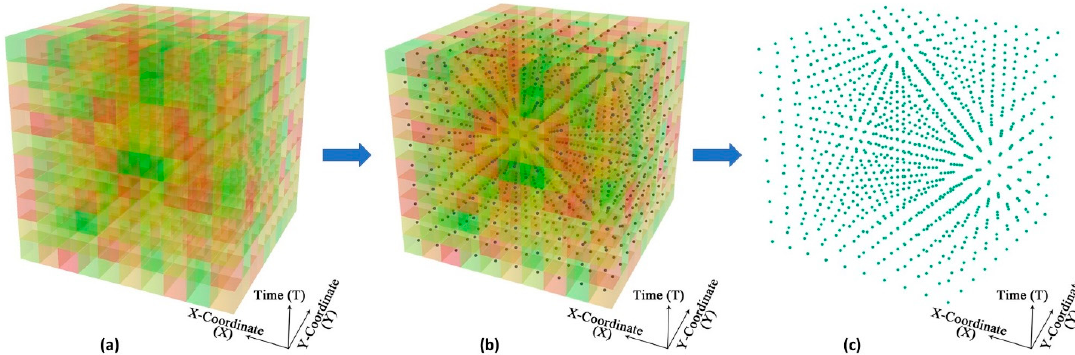
Figure 5. Implementation of the 3-D environmental context cube using a 3-D point cloud. ( a ): an environmental context cube, ( b ) voxels in the cube represented by points at the centroid of the original voxels, ( c ) the corresponding 3-D point cloud.